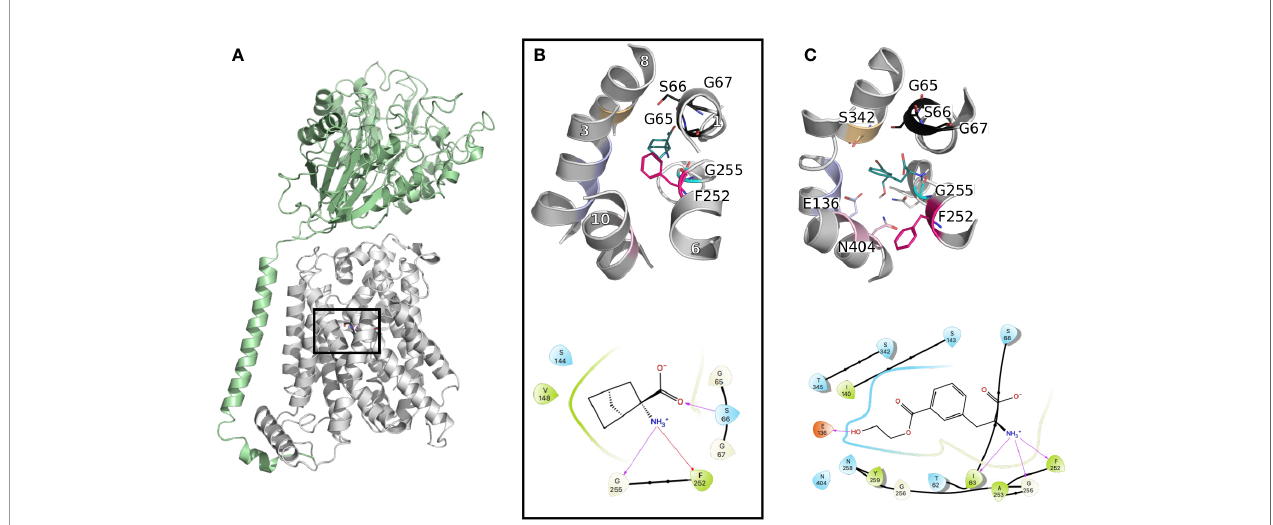
FIGURE 3 | LAT1 binding site. (A) The cryo-electron microscopy (EM) structure of the LAT1-4F2hc complex (PDB ID 6irt (Yan et al., 2019)) is represented in cartoon. 4F2hc is shown in green and LAT1 bound to 2-amino-2-norbornanecarboxylic acid in gray, from a side view, parallel to the membrane plane. (B) Close up representation of the binding site from a top view. Important residues de fi ning the binding site are labeled and shown in lines with the same color code as in Figure 1 , and the helices are labeled in white. (C) Binding pose of a new reported potent substrate resulting from a study on a homology model of LAT1 (Chien et al., 2018). The bottom panels (B, C) show the two-dimensional representation of the LAT1 interaction with its